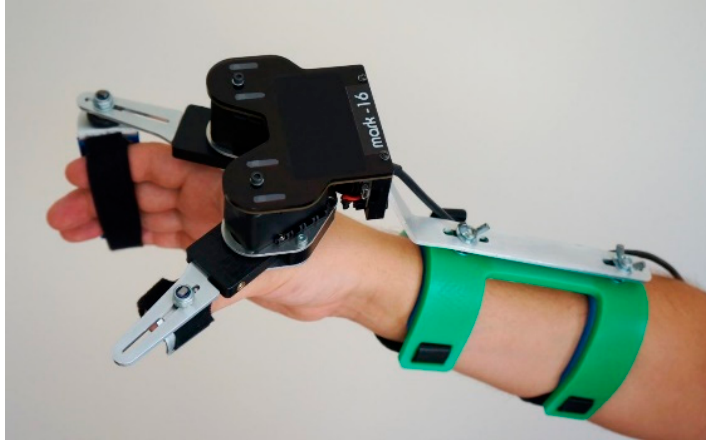
Figure 2. Example of a rehabilitation hand robot constructed in Poznan University of Technology.